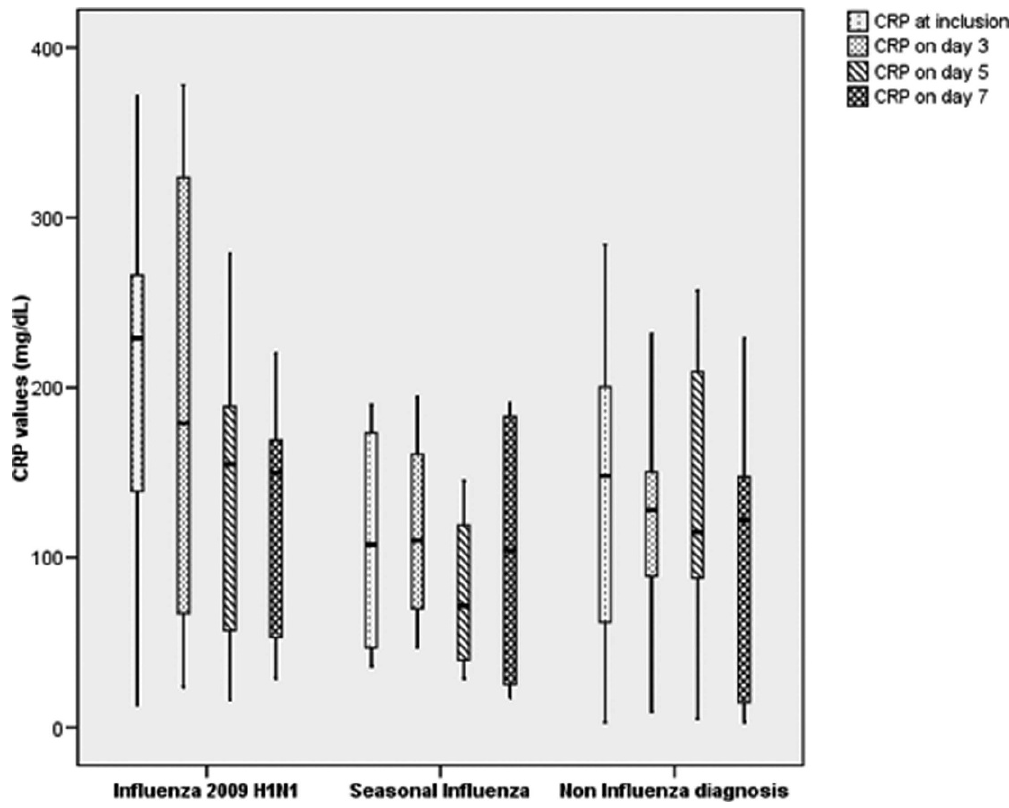
Figure 2 - The circulating levels of C-reactive protein observed in the studied patients at the four points of measurement, according to the respective